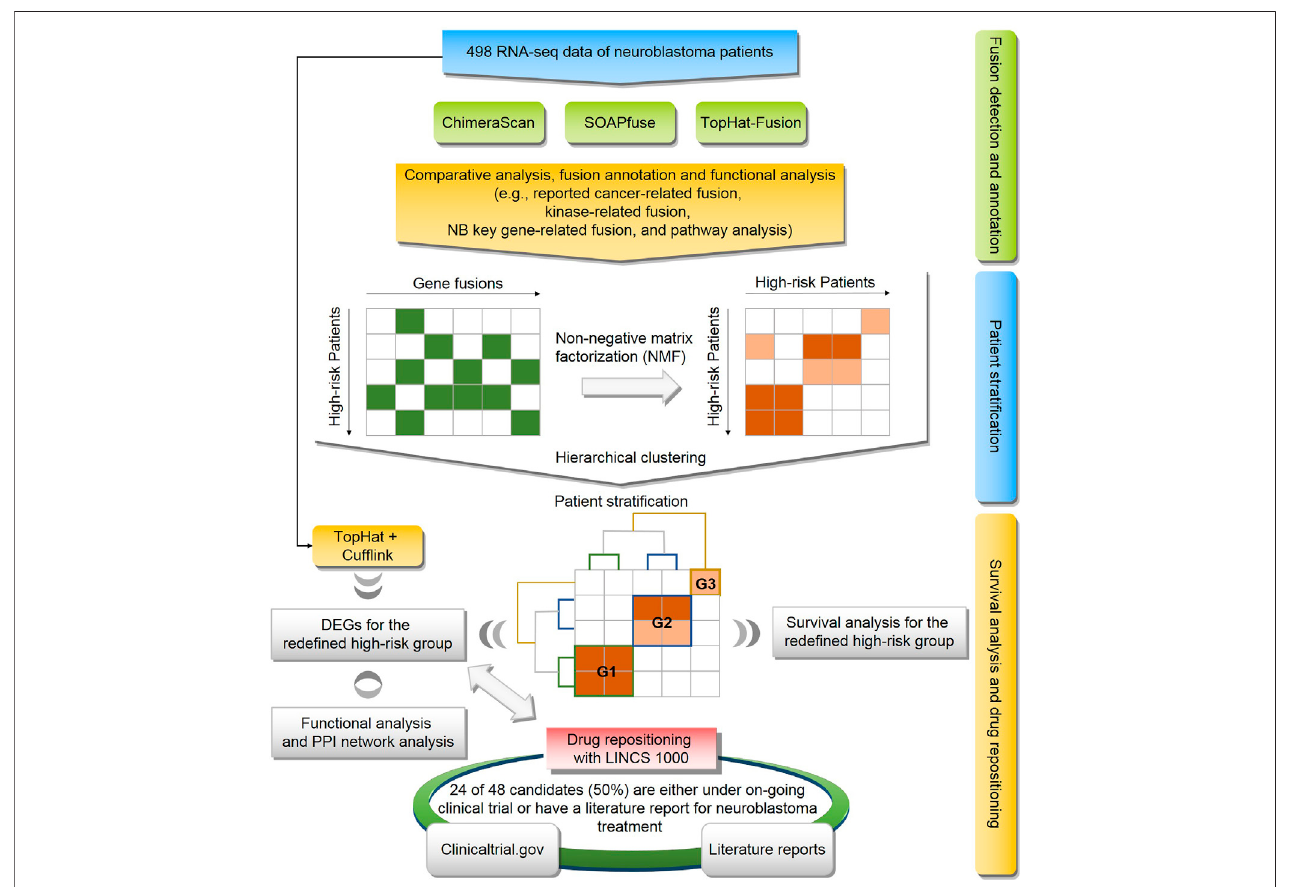
FIGURE 1 | Flowchart of study: the work fl ow consists of three components including (1) fusion detection by three algorithms (i.e., ChimeraScan, SOAPfuse, and TopHat-Fusion) and fusion annotation by publicly available database and pathway analysis; (2) The high-risk patients were regrouped based on gene fusion pro fi les using non-negative matrix factorization (NMF) and hierarchical cluster analysis (HCA); (3) Survival analysis and drug repositioning for the rede fi ned patient